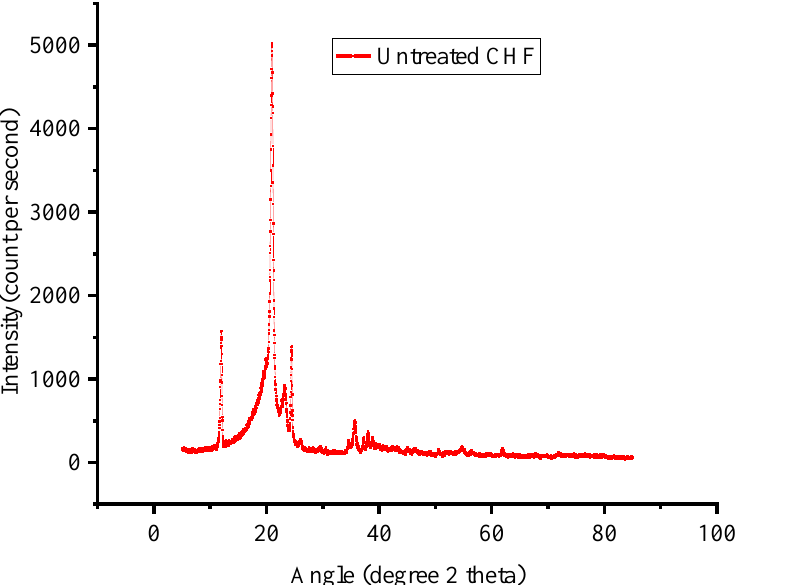
Figure 9. Diffraction of X-rays of untreated composites.